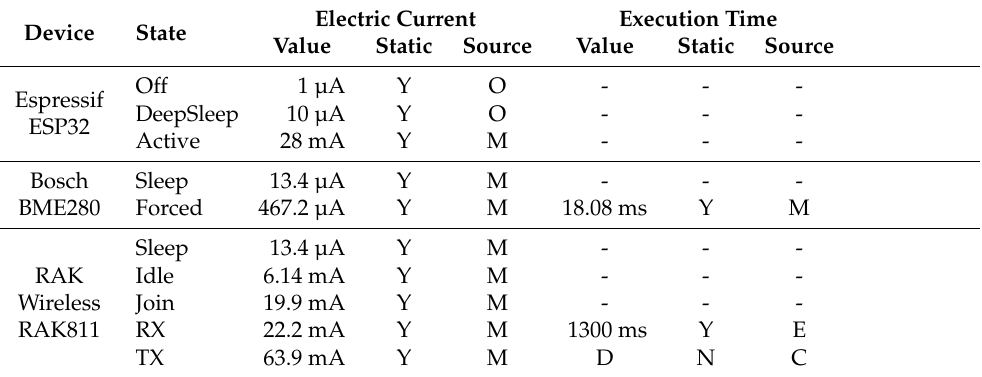
Table 1. Overview of the operational states, power consumption and execution times for the compo- nents of the beehive microclimate sensor node. Unused operational states have been